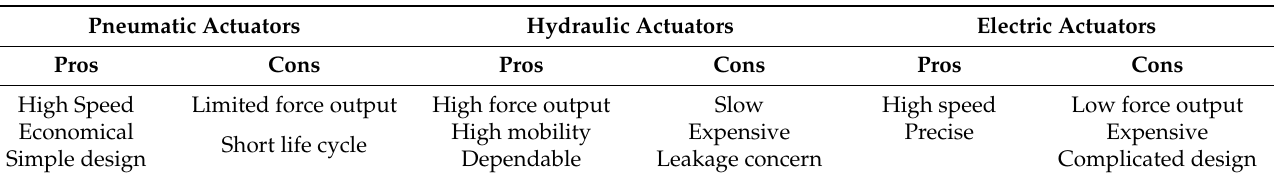
Table 1. Comparing actuation methods for exoskeletons. Adapted from